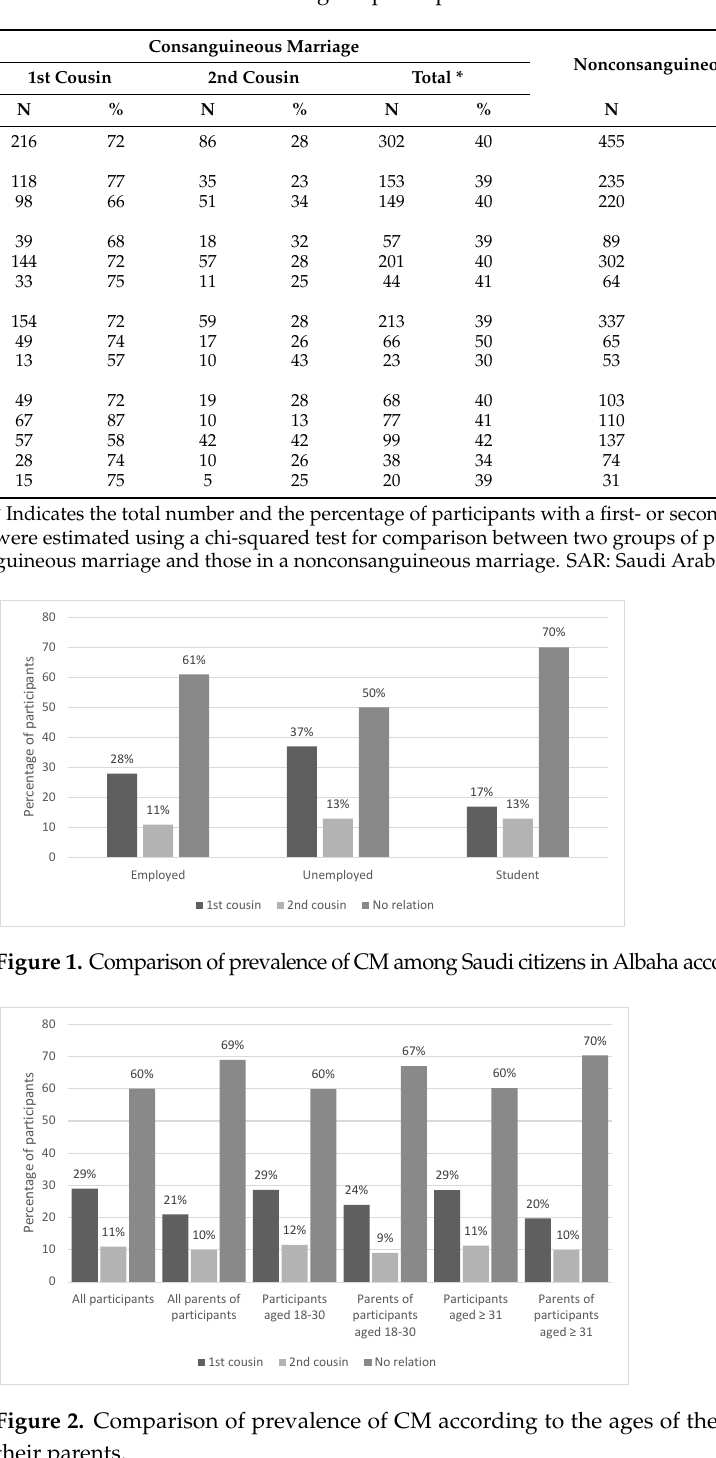
Table 2. Prevalence of CM among the participants.